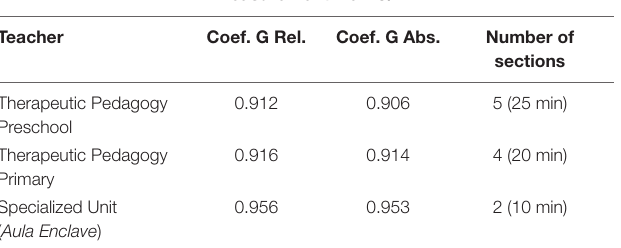
TABLE 4 | Time sections optimization.